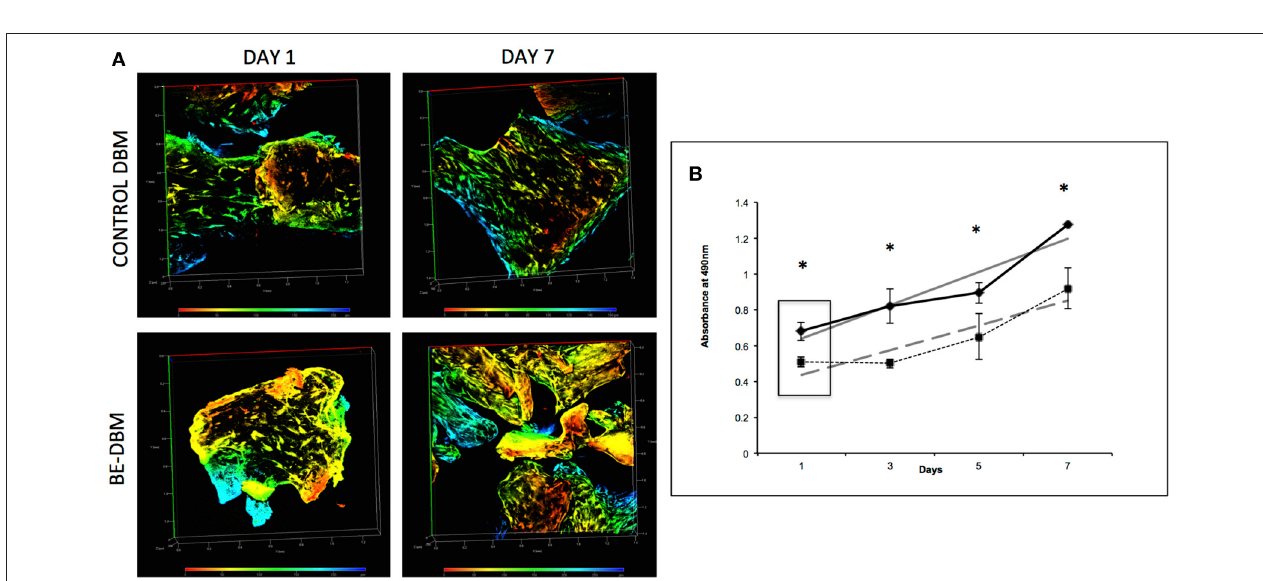
FIGURE 2 | Electron microscopic evaluation of DBM and BE-DBM. Images are representative electron micrographs of DBM (A,B) , DBM with HMSCs (A1,B1) and BE-DBM (A2,B2) . Panels (A,A1,A2) are low magnification images. Panels (B–B2) are higher magnification images showing the microstructure. The white arrows in (A1,B1) point to the cells. White arrows in (A2,B2) point to ECM deposition in the BE-DBM samples. Note the absence of such structures in images (A,B) .